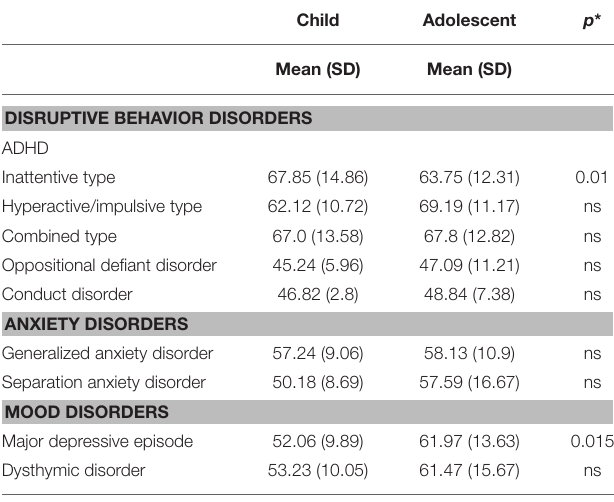
TABLE 3 | Proportion of participants (%) by Distribution of clinically significant T-scores on the CASI-5. T-score < 65 > 65